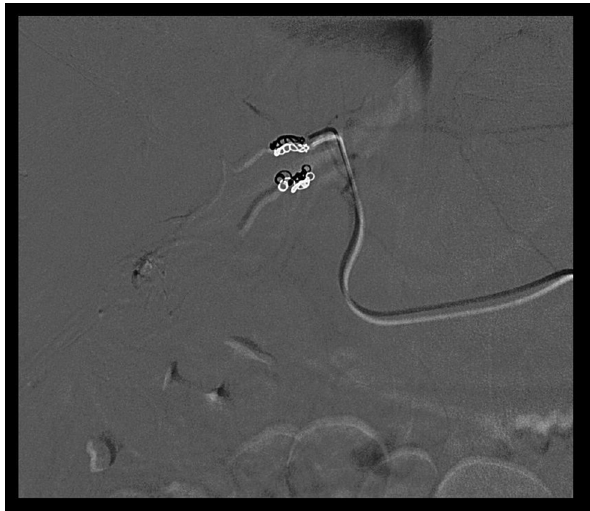
Figure 3: Metal microspirals and devascularizated